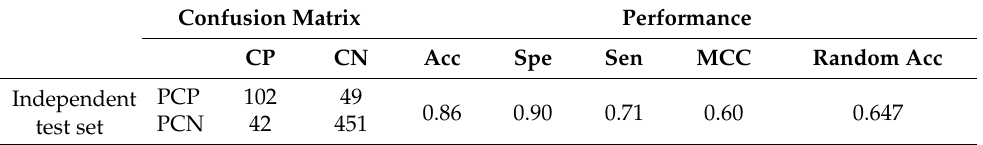
Table 1. The performance of the optimal LR model on the 644 test